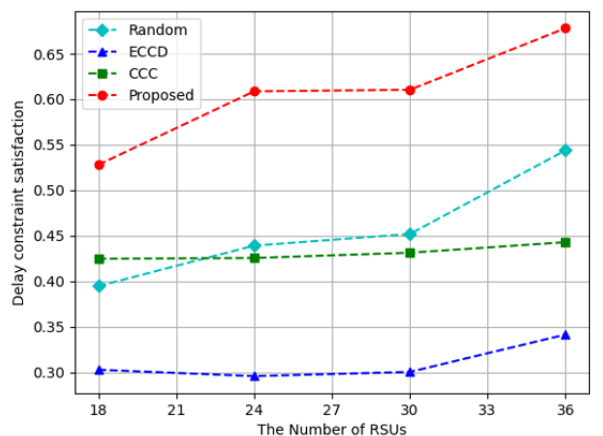
Figure 7. Throughput with respect to the increase in the number of RSUs.